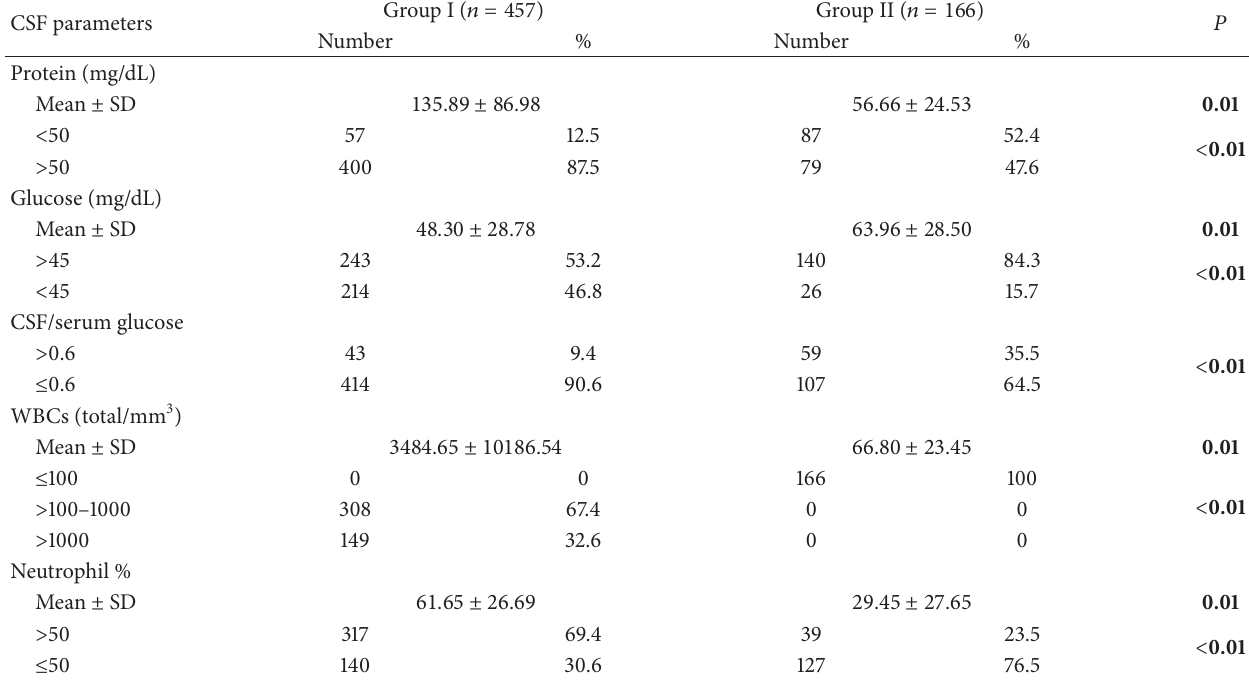
Table 5: CSF parametersmarkers inbacterial and aseptic meningitis groups in the studied population.